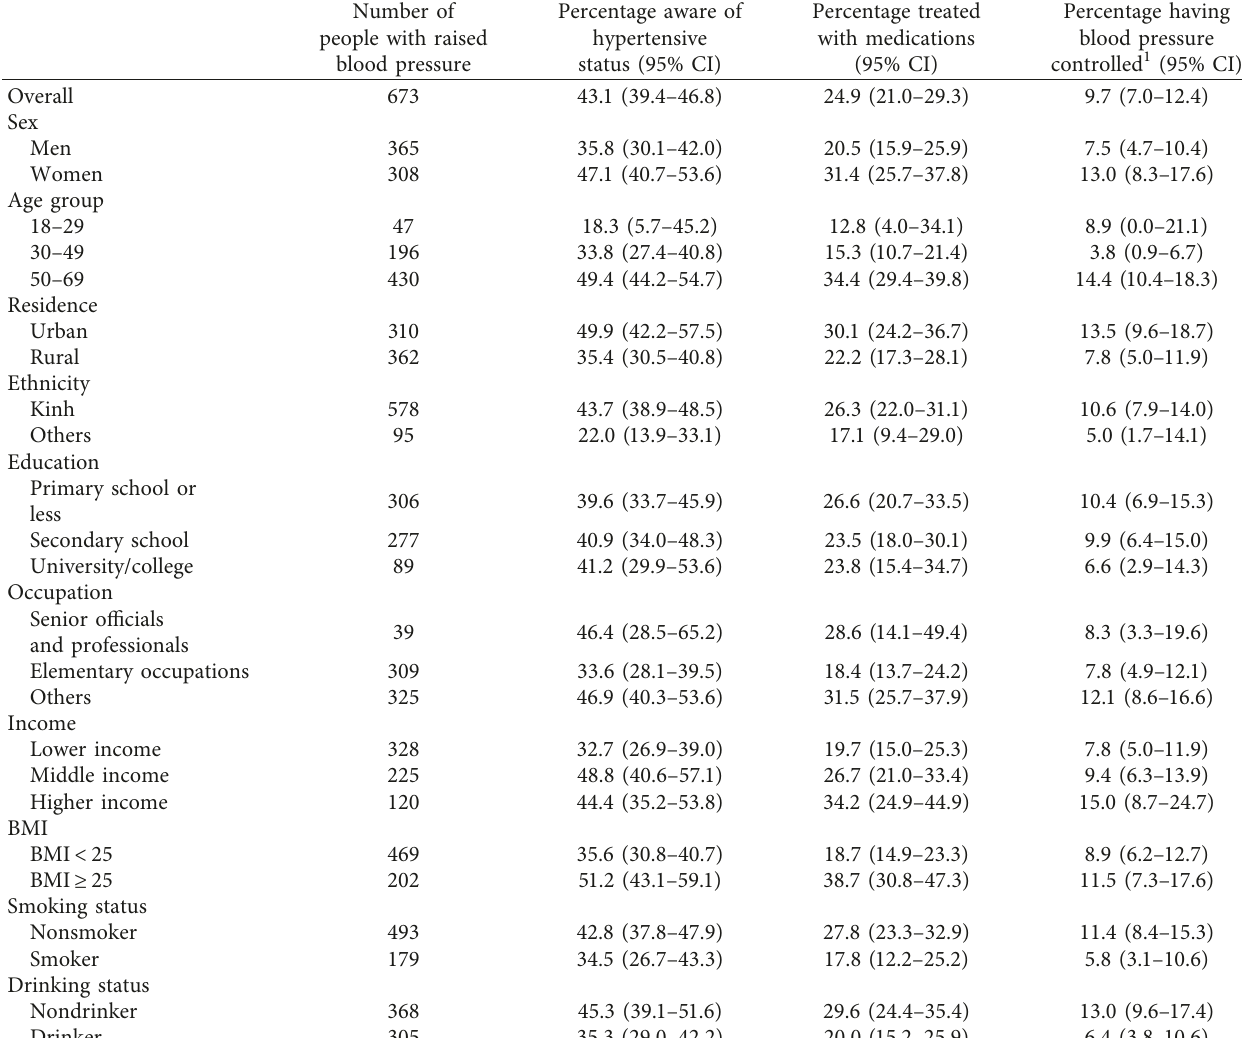
Table 2: Proportions of hypertensive people who were aware of their hypertensive status, being treated with medications, and had their high blood pressure controlled, Vietnam